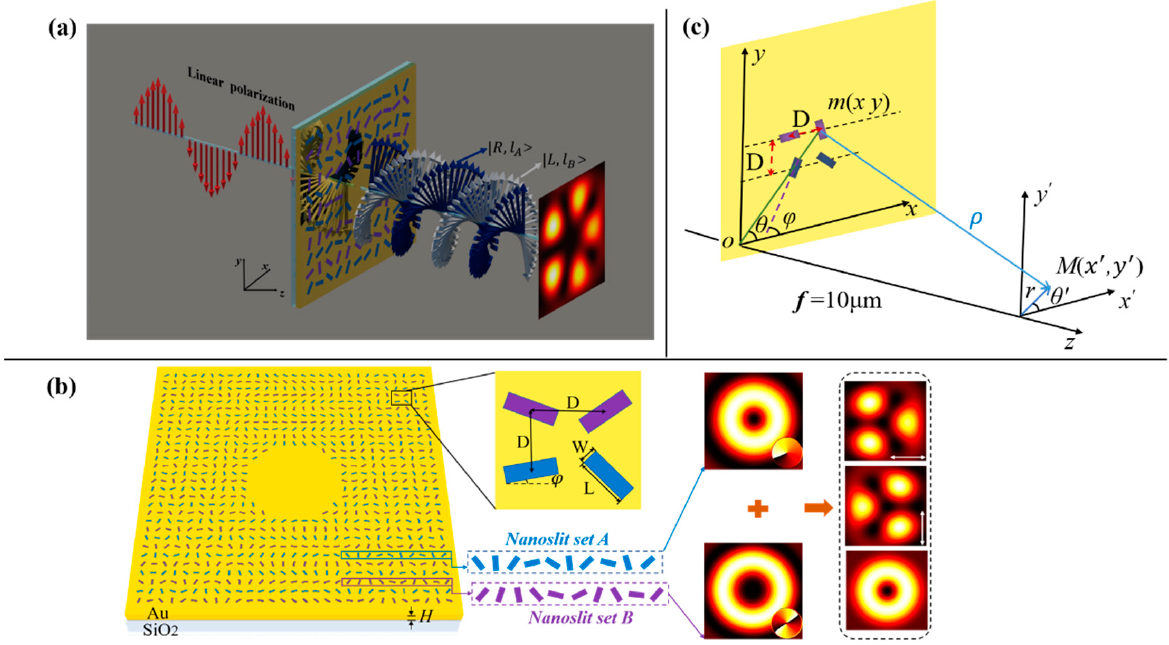
Figure 1. ( a ) schematic of generation of vector light field by illumination of linearly polarized (LP) light. ( b ) schematic of the metasurface and detailed view of a single slit: The length (L) and width (W) of a single slit are 250 nm and 80 nm, respectively; a slit-to-slit spacing D in both x -and y -directions; the thickness of the gold film is H = 200 nm; and the nanoslit set A and set B are arranged alternatively in the y -direction generate two vortices | R, l A > and | L, l B > of right circular polarization (RCP) and left circular polarization (LCP) with the topological charges l A and l B , respectively, the superposition of two focused vector vortices can produce the vector fields. ( c ) sketch map of optical geometry for light propagations and light field generation.